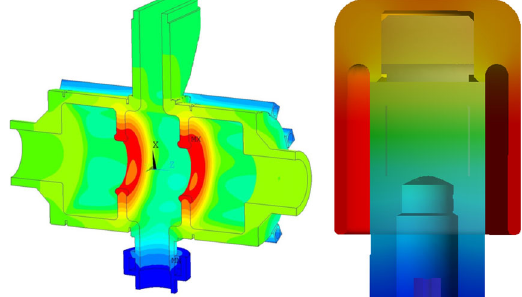
FIG. 9. Temperature distribution with 9 kW total power dissipation at 250 kV accelerating voltage (left) on the 2.1 GHz cavity wall with a maximum temperature at 69 °C and (right) on the tuner with a maximum temperature at 155